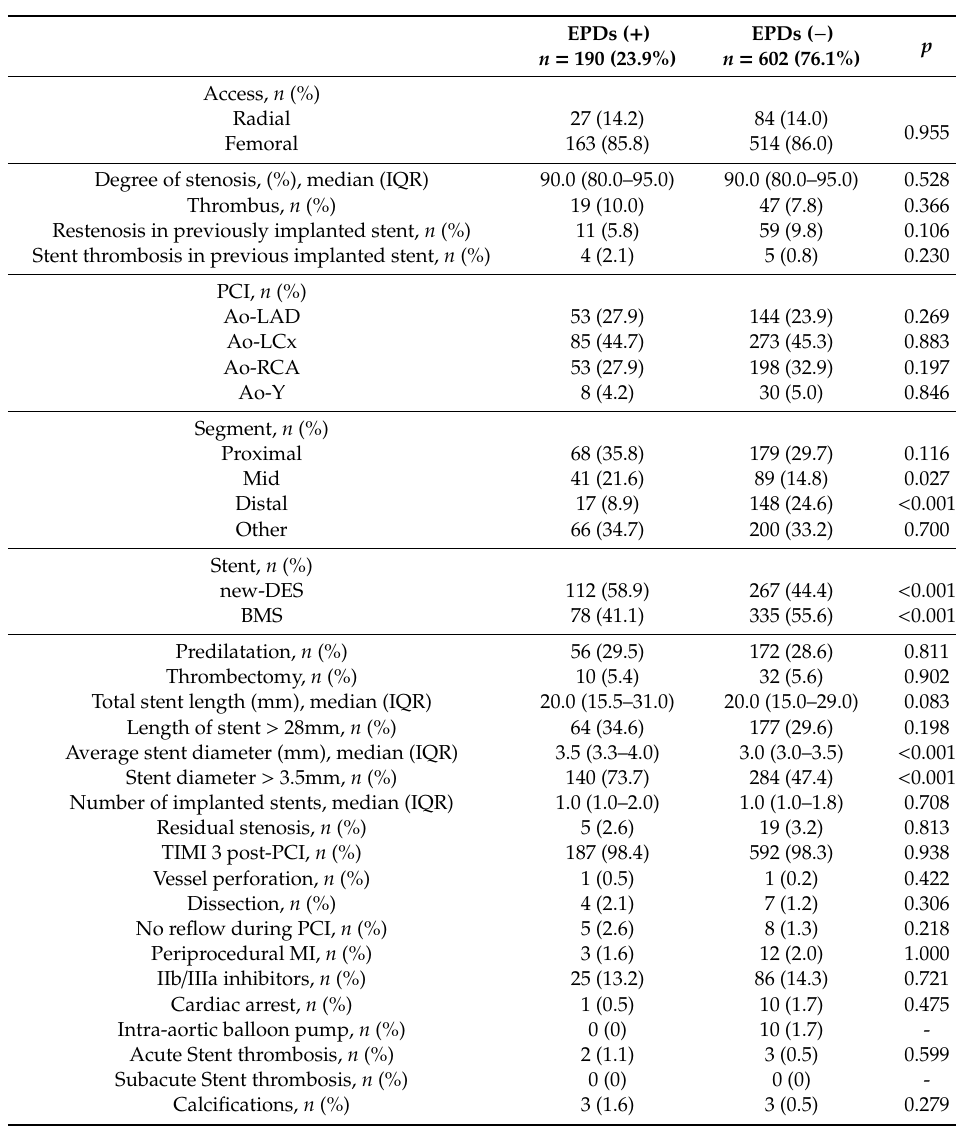
Table 2. Angiographic and procedural data according to the use of embolic protection